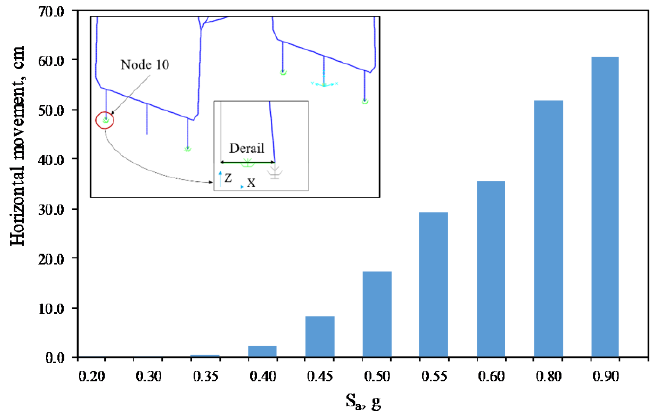
Figure 9. Horizontal movement of the landside leg (node 10) for the FC boundary.